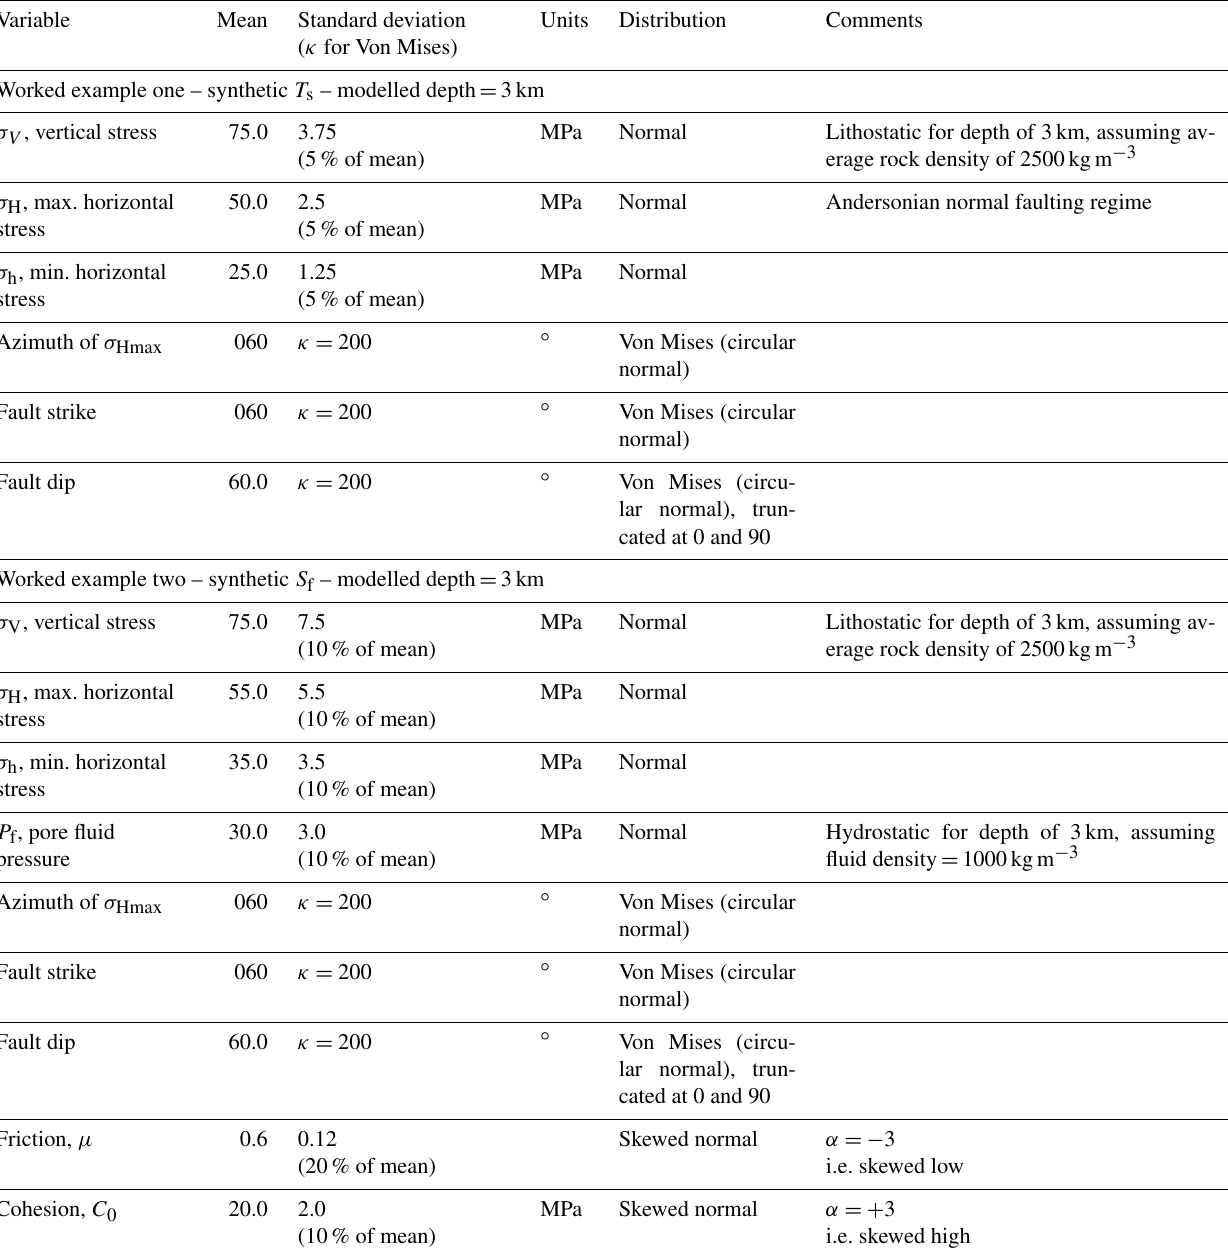
Table 2. Table of input variable distributions for the synthetic models in worked examples one and two. Variable Mean Standard deviation Units Distribution ( κ for Von Mises)